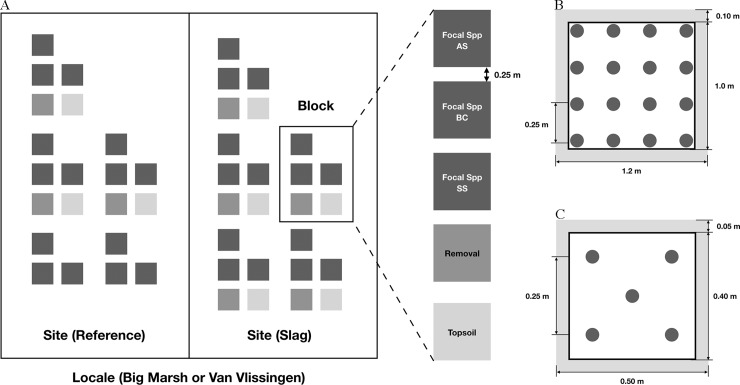
Experimental setup and plot maps.(A) General map showing number of plots, and relationships between locale, site and block, with configuration within each block; each plot is randomly ordered and separated by at least 0.25 m. (B) Configuration of 16 individuals within each BC and SS focal species plot. (C) Configuration of 5 individuals within each AS focal species plot.